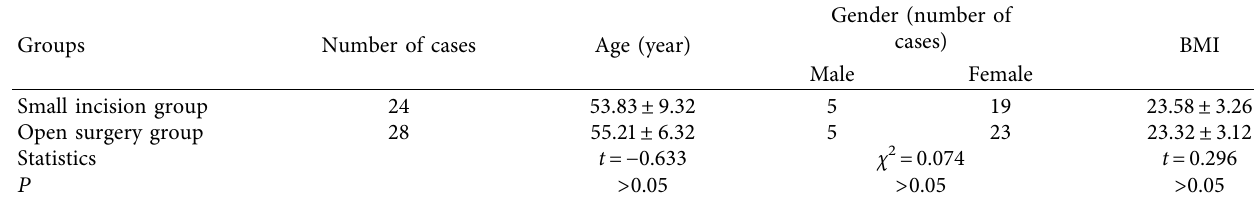
Figure 2: A longitudinal incision placed in the radial border of the ring finger line, which begins about 1cm to the distal flexor wrist crease (dotted lines are the Kaplan cardinal line and radial side ring finger and the solid line is an incisional site). (a) The incised skin was retracted with the help of a miniretractor, subcutaneous fat tissue was dissected, and the ligament was cut with a surgical blade. (b) The wrist joint was flexed palm forward, and the ligament was released to the level of the distal flexor wrist crease. (c) The wrist joint was extended dorsally, and the branch of the median nerve could be released under direct vision (d). Table 1: Comparison of the general characteristics between the two groups of patients.